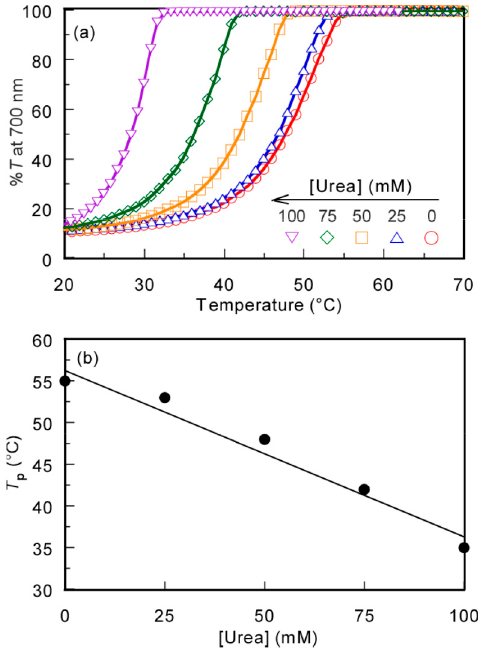
Figure 6. ( a ) Percent transmittance (% T ) at 700 nm for the PMPC/PAAc mixed aqueous solution with f AAc = 0.85 at C p = 0.5 g/L, pH 3, and [NaCl] = 0.1 M as a function of temperature in the presence of urea; and ( b ) T p as a function of urea concentration ([Urea]).